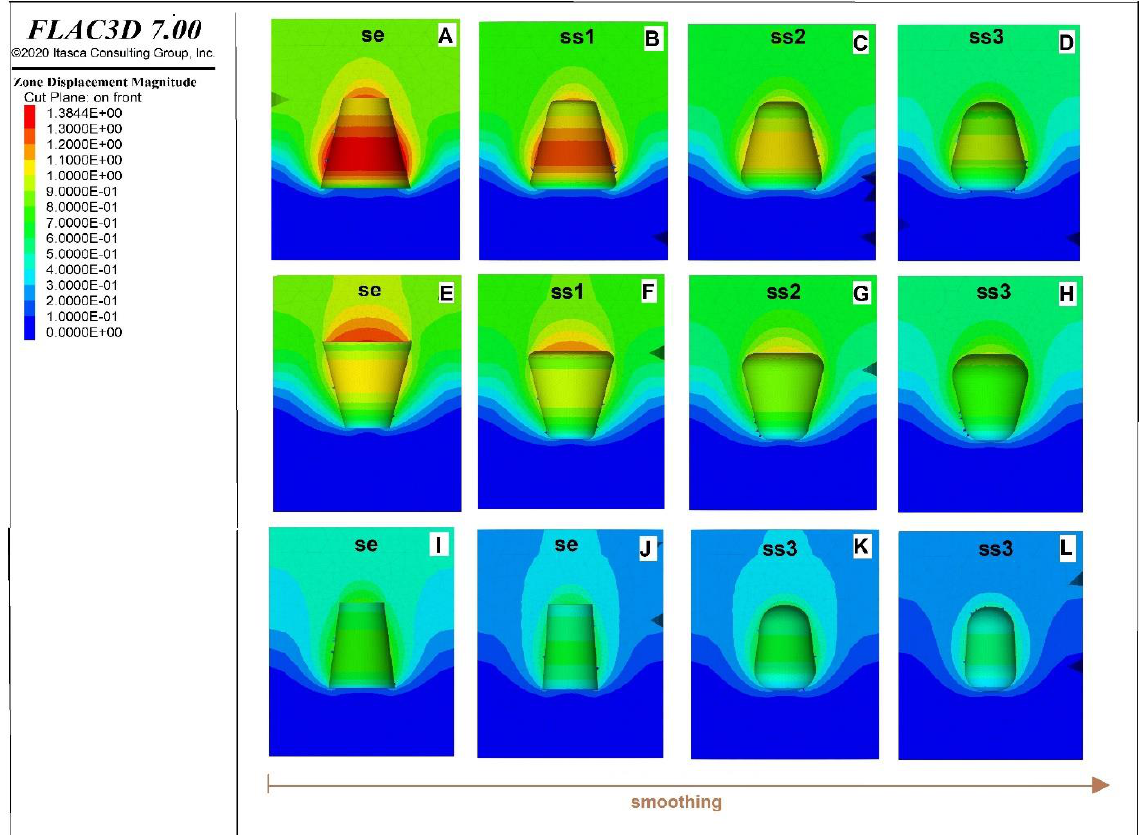
Figure 5. The displacement value and distribution in simulated caverns, first withdrawal period: ( A – D ), ( I – L ) enlarged bottom, ( E – H ) enlarged top, ( A – H ) maximum initial diameter of 120 m, ( I , K ) maximum initial diameter of 90 m, ( J , L ) maximum initial diameter of 75 m.